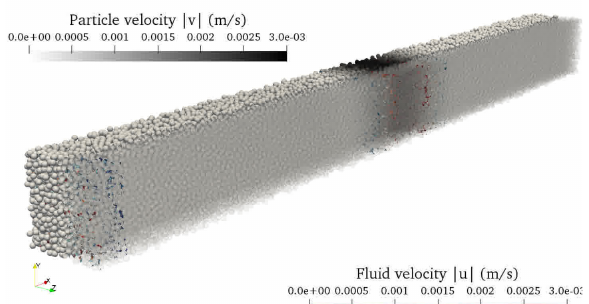
Figure 1: Snapshot of a propagating wave in a fluid- saturated granular material.